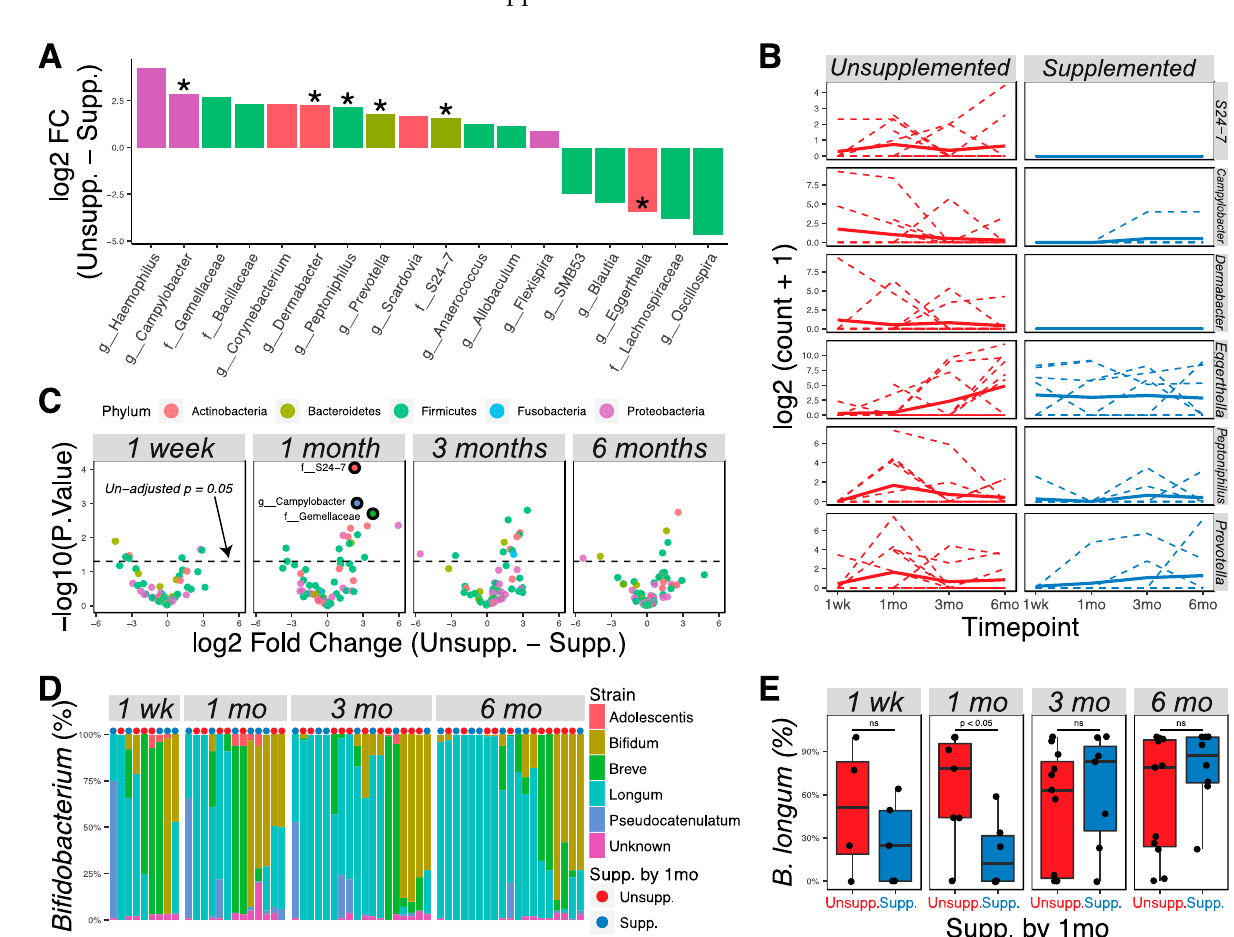
Figure 3. Supplementation by 1 month of age was correlated with abundance of specific microbial taxa at 1 month and 3 months of age. ( A ) Bacterial taxa that were differentially abundant as detected by the limma–voom regression method ( p < 0.05; * adjusted p < 0.05). Taxa with positive numbers are more abundant in unsupplemented infants; taxa with negative numbers are more abundant in supplemented infants. Taxa were colored according to phylum membership. ( B ) Representation of significantly changed taxa at each time point in unsupplemented and supplemented infants. Solid lines show the mean abundance; dashed lines show the individual level. ( C ) Volcano plots show significantly different taxa between unsupplemented and supplemented infants at different time points. Markers for taxa having significant adjusted p values (<0.05) are circled in black. ( D ) Bif-TRFLP analysis of Bifidobacterium species. Samples were ordered using the Bray–Curtis dissimilarity index and Ward D clustering method. ( E ) Boxplots showing the percentage abundance of Bifidobacterium longum among all bifidobacteria at different time